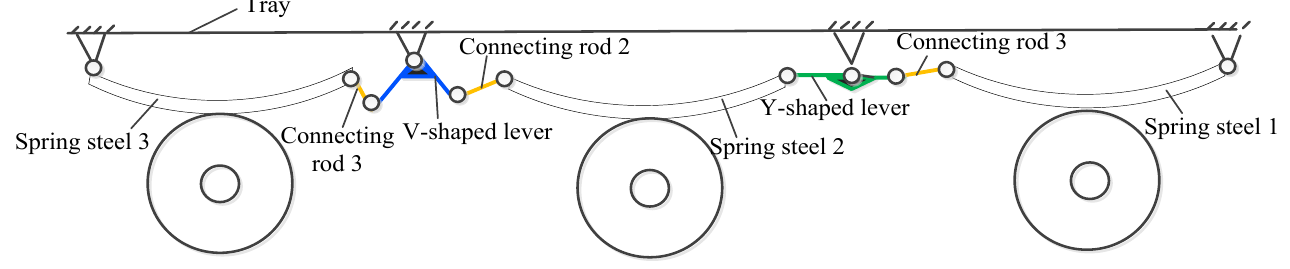
Figure 2. Structure diagram of floating mechanism.